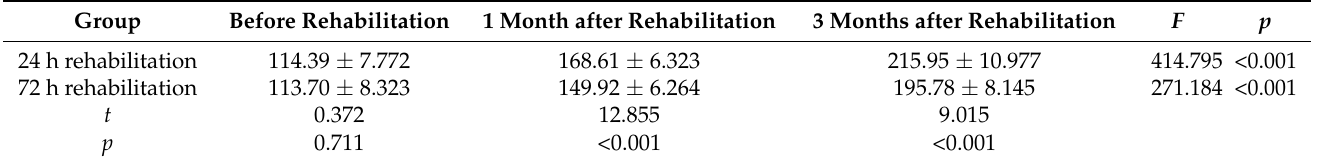
Table 4. Quality of life scores of the acute ischemic stroke patients before and after rehabilitation ( x ± s, n =